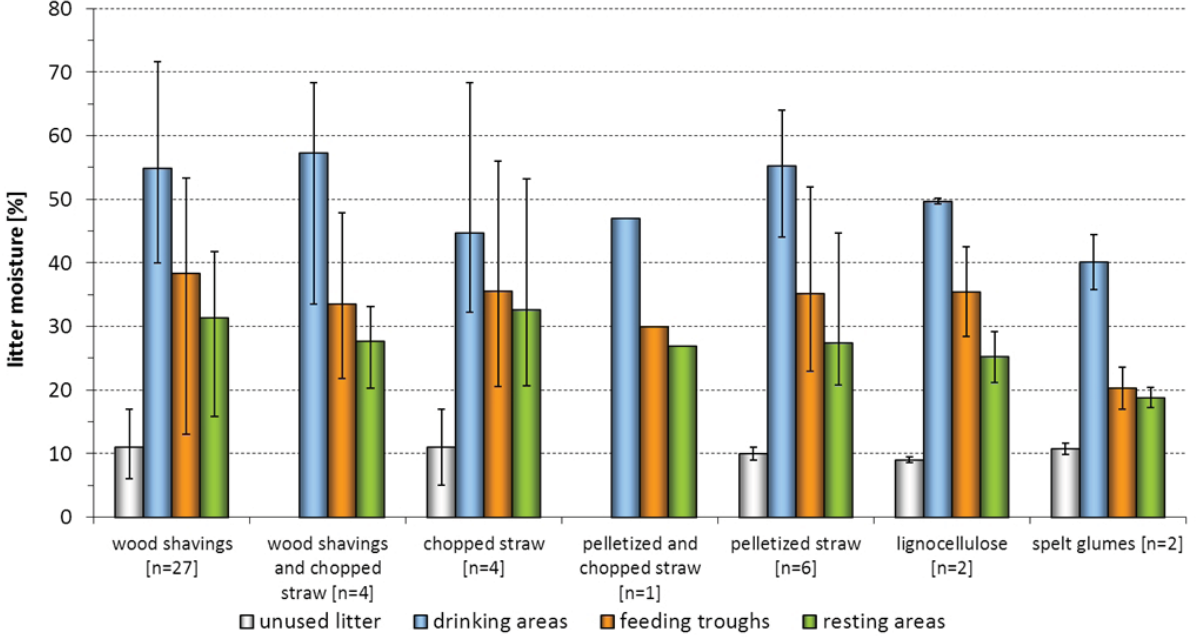
Figure 5. Percental litter moisture of different litter materials and defined sample areas. The moisture measurements of collective samples on Day 22 to 35 solely resulted in eight out of 46 rearing periods with a litter moisture below the critical 30%.